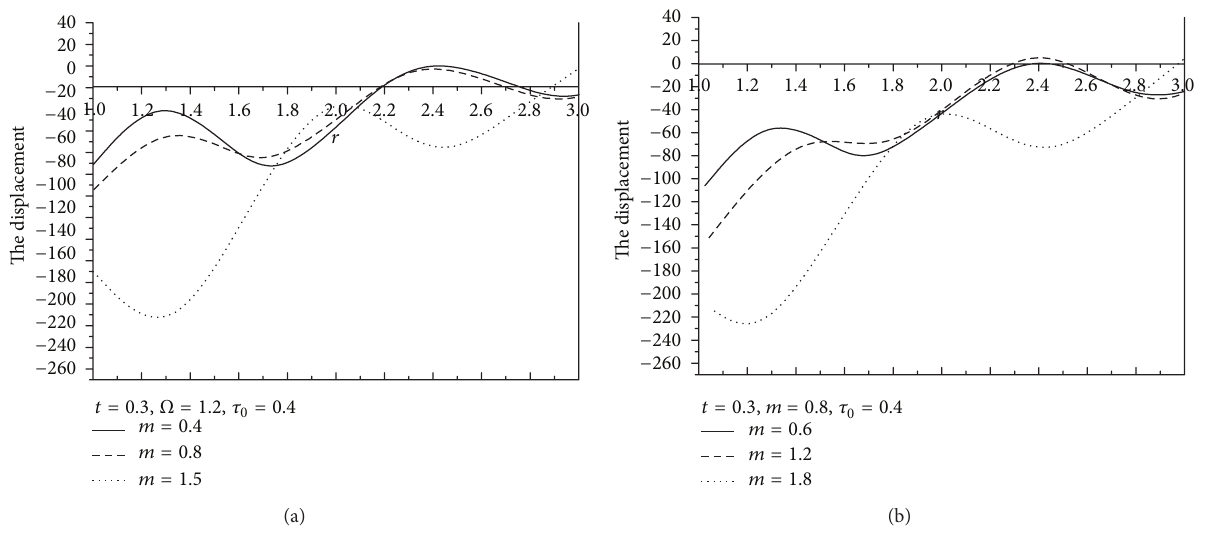
Figure 4: Variation of displacement 𝑢 with radius 𝑟 (thermoelastic diffusion nonhomogeneity